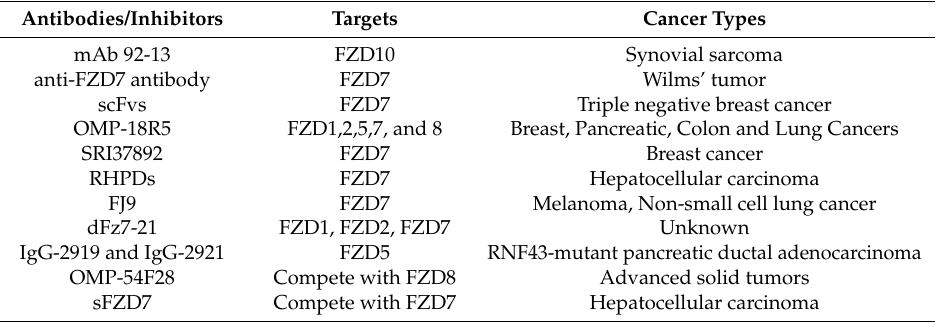
Table 2. FZD antibodies/inhibitors for various